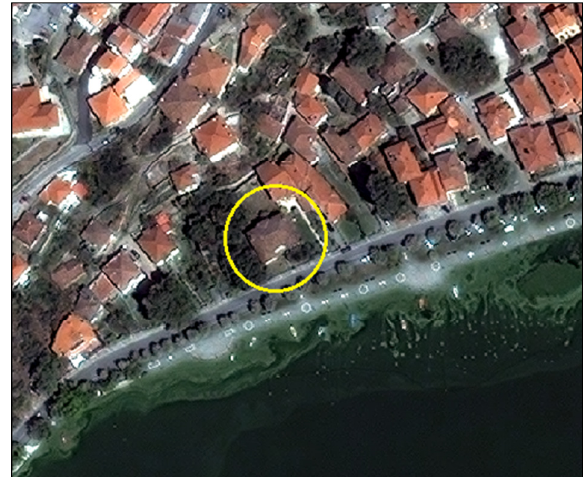
Figure 4. Skoutaris Mansion in the yellow circle (QuickBird subset image in true color